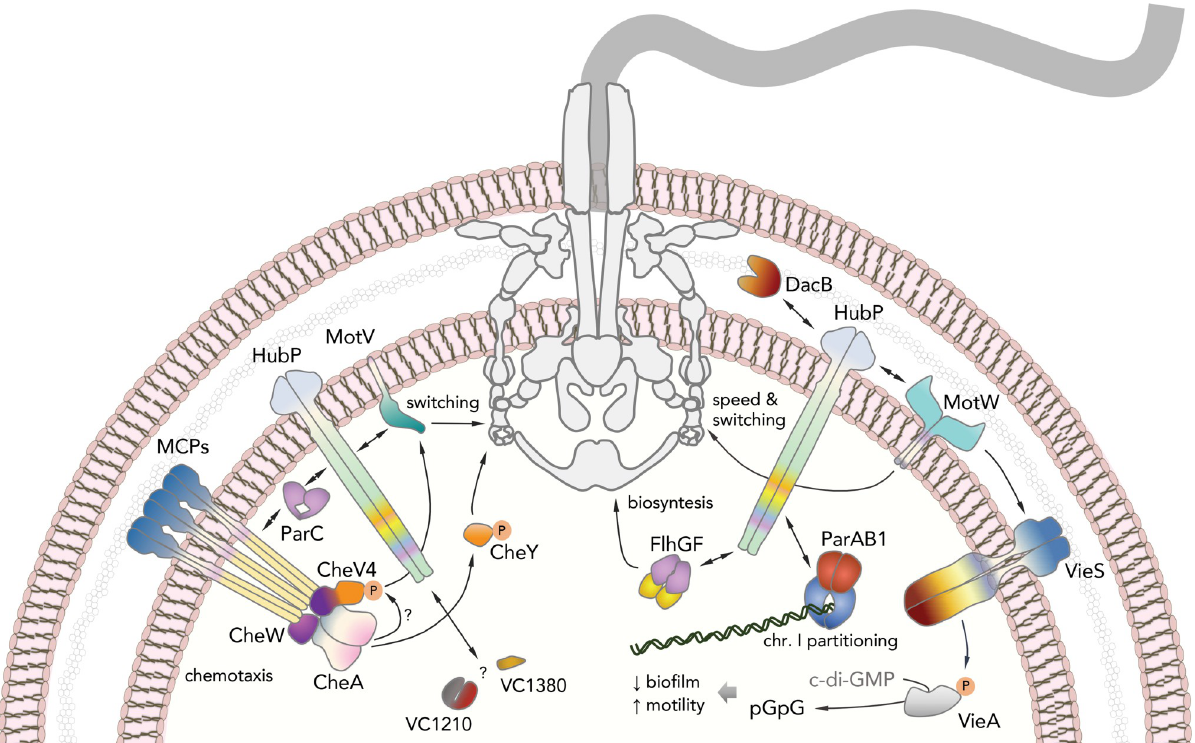
Fig 6. HubP-dependent cell pole organization. Proposed integrated model for HubP-dependent cell pole organization and functional linkages among HubP, identified partners, flagellar motility, chemotaxis signaling and c-di-GMP signaling pathways. The thumbnail representation of the flagellum is adapted with modifications from [45], under the license CC BY 4.0 (https://creativecommons.org/licenses/by/4.0/legalcode).